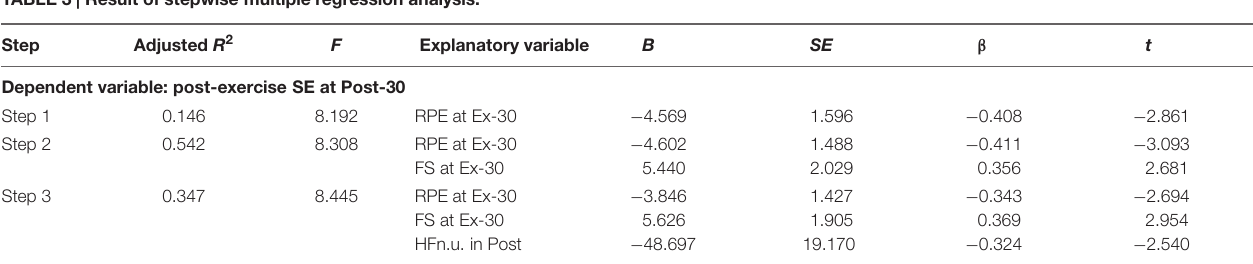
TABLE 3 | Result of stepwise multiple regression